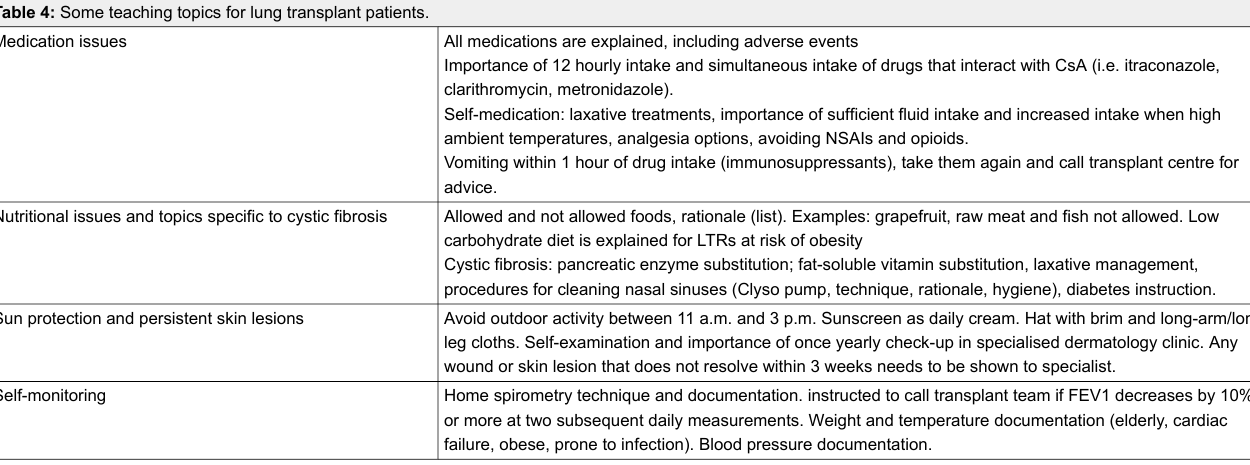
Table 4: Some teaching topics for lung transplant patients. Medication